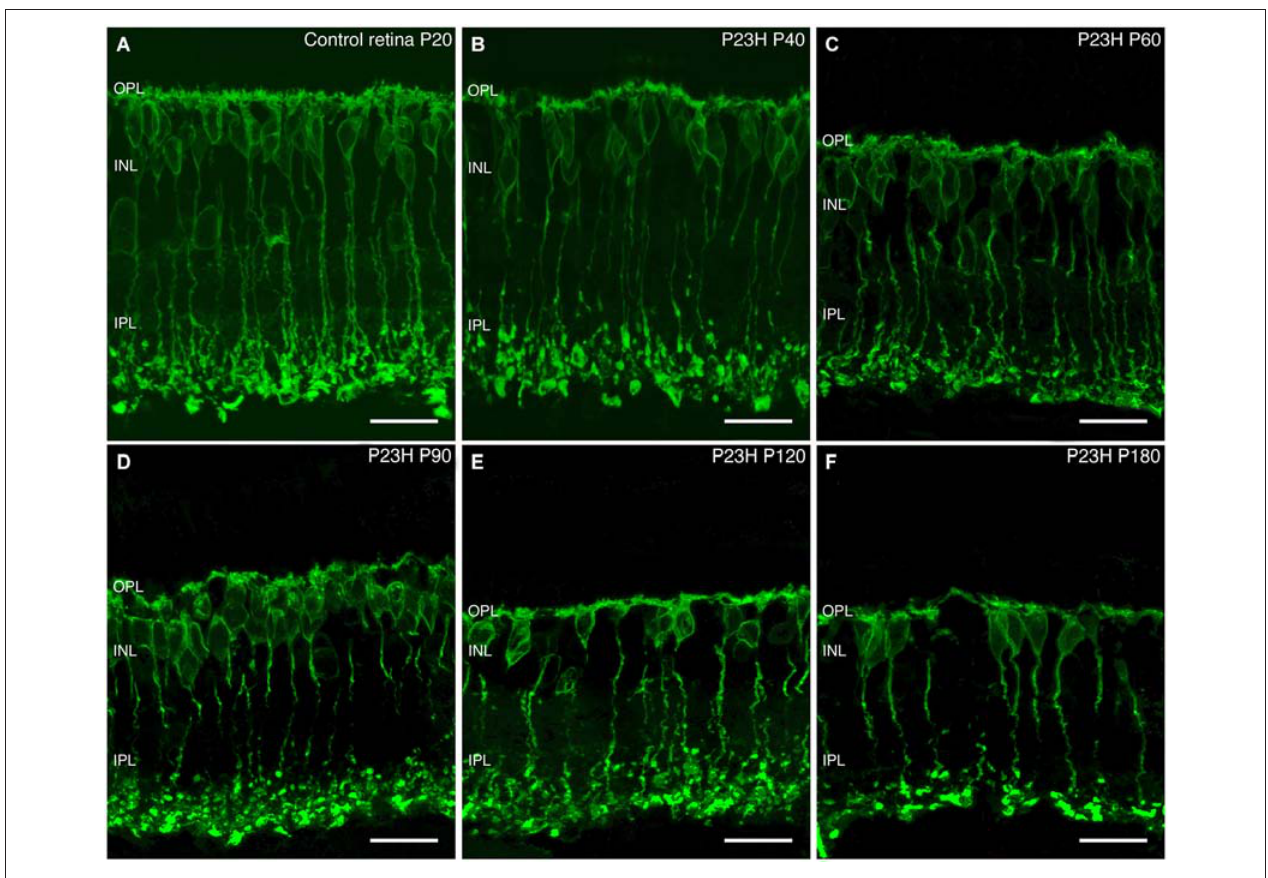
started at P60; from this age and onward, there is a shortening of rod bipolar dendrites, a decrease in their immunoreactivity and loss of bipolar axon terminals. OPL: outer plexiform layer; INL: inner nuclear layer; IPL: inner plexiform layer. Scale bar: 20 µ